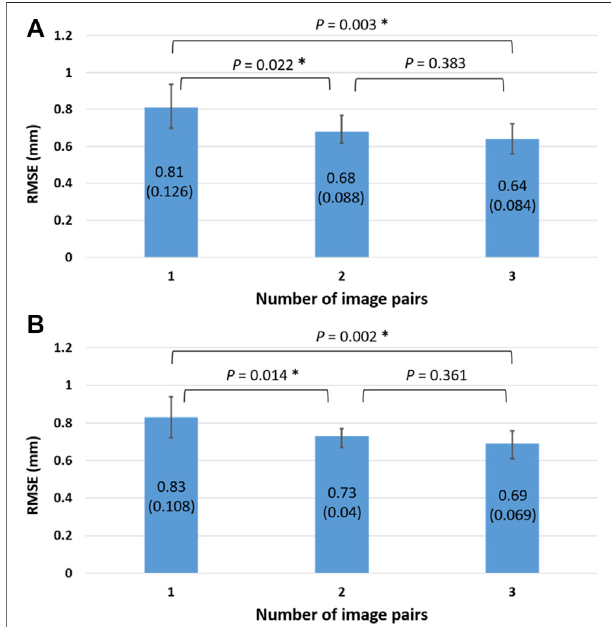
FIGURE 5 | The means (standard deviations) of the RMSE (unit: mm) for the invivo femur (A) andtibia (B) shapereconstructionusing1,2,and3image pairs. The asterisks indicate signi fi cant differences ( p < 0.05).